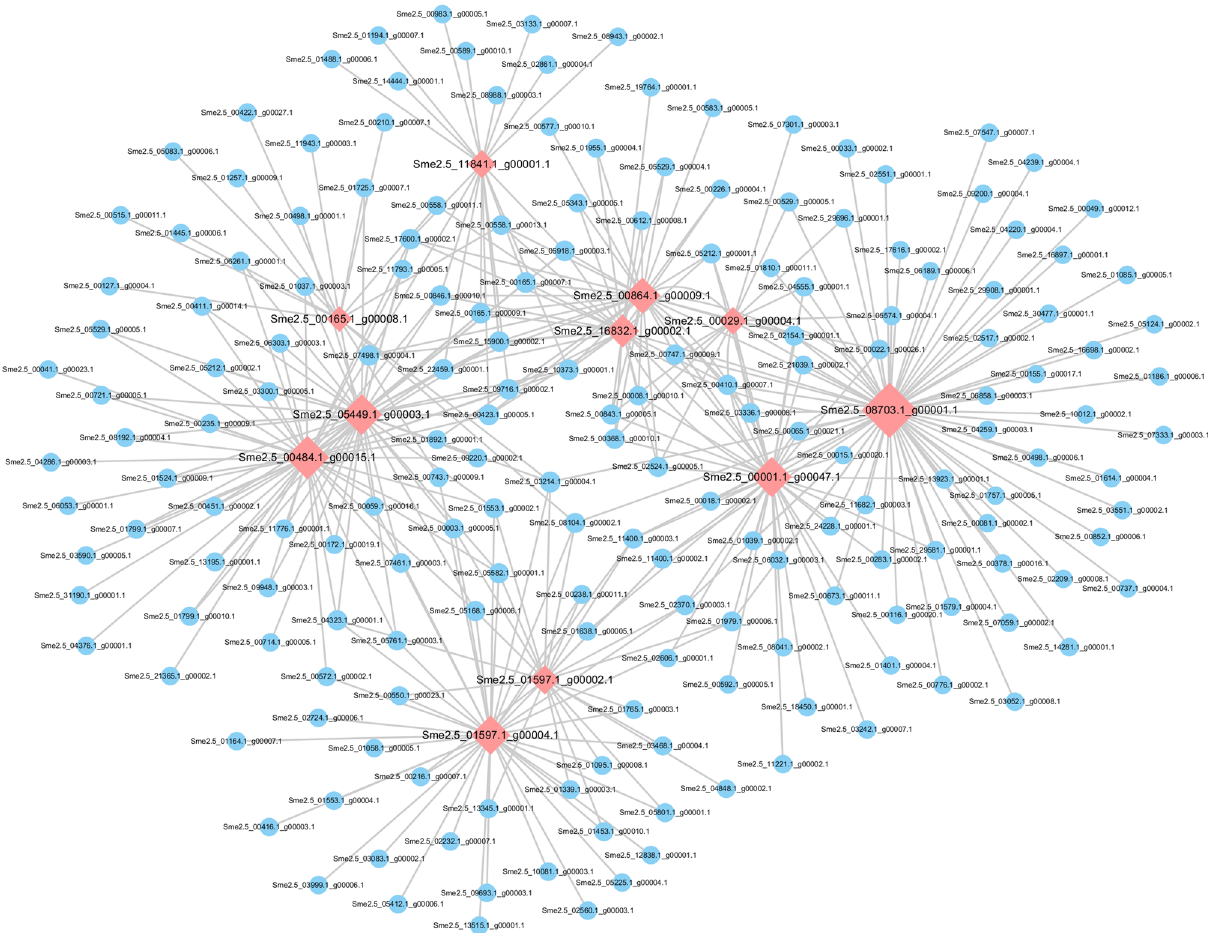
Figure 9. Gene regulatory networks of the KEGG pathway ko00360 (phenylalanine metabolism). Cytoscape v3.6.0 (https:// cytos cape. org/) was used to create the